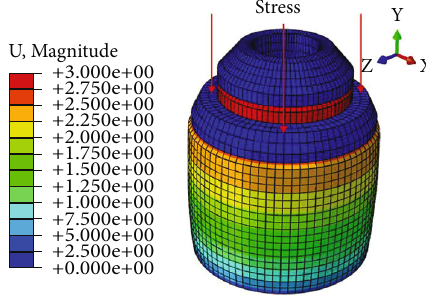
Figure 6: FEA model of the